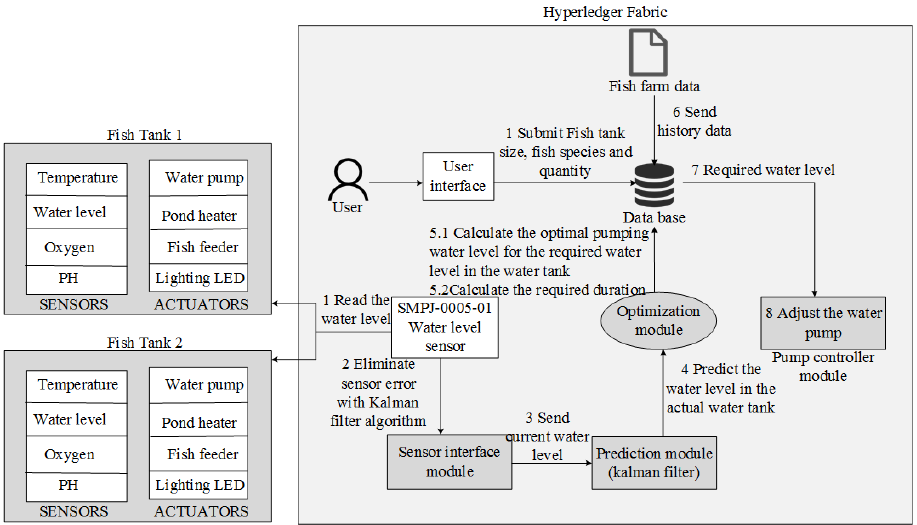
Figure 19. Reconstruction diagram of reference [44].